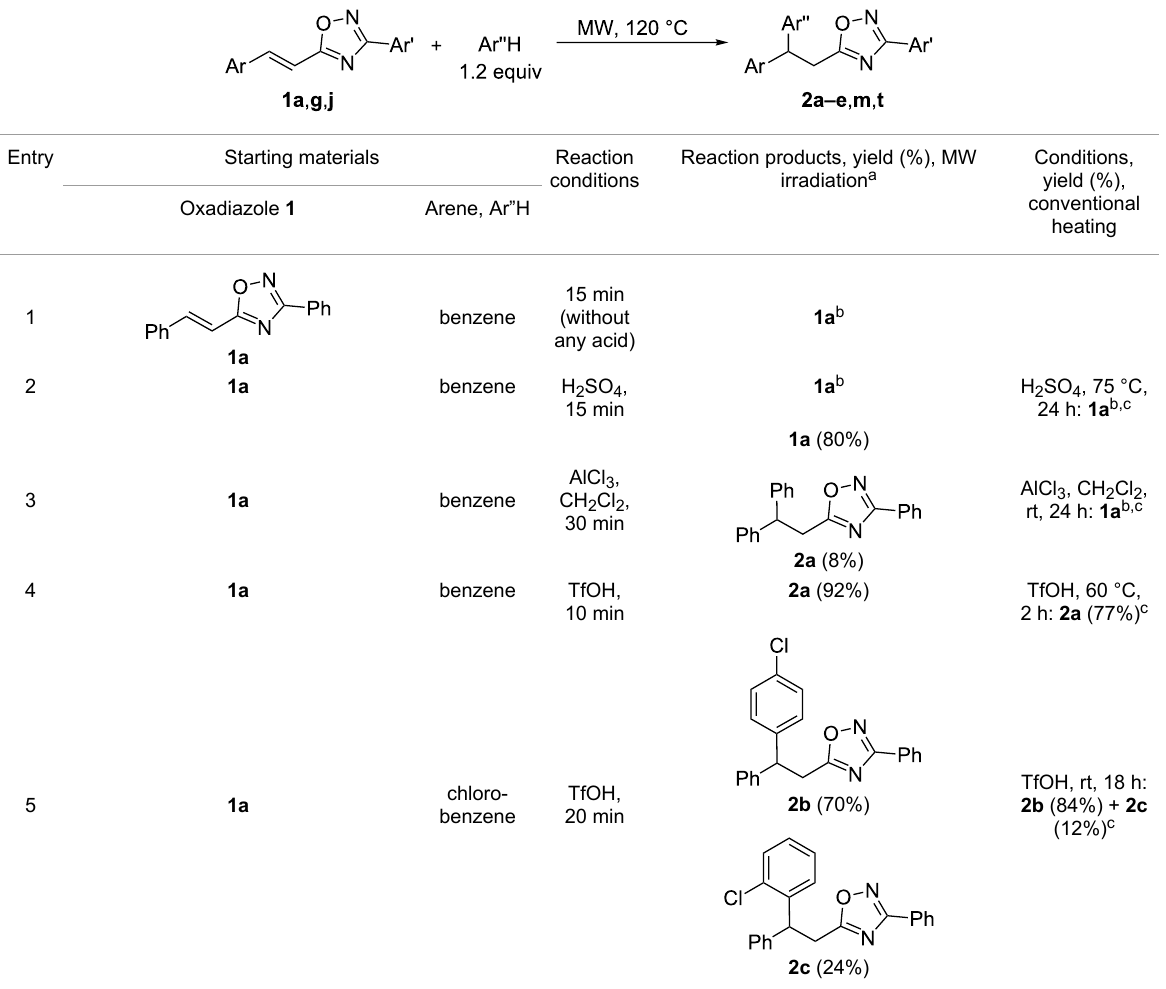
Table 3: Hydroarylation of oxadiazoles 1 with arenes under microwave (MW) activation in TFOH at 120 °C.